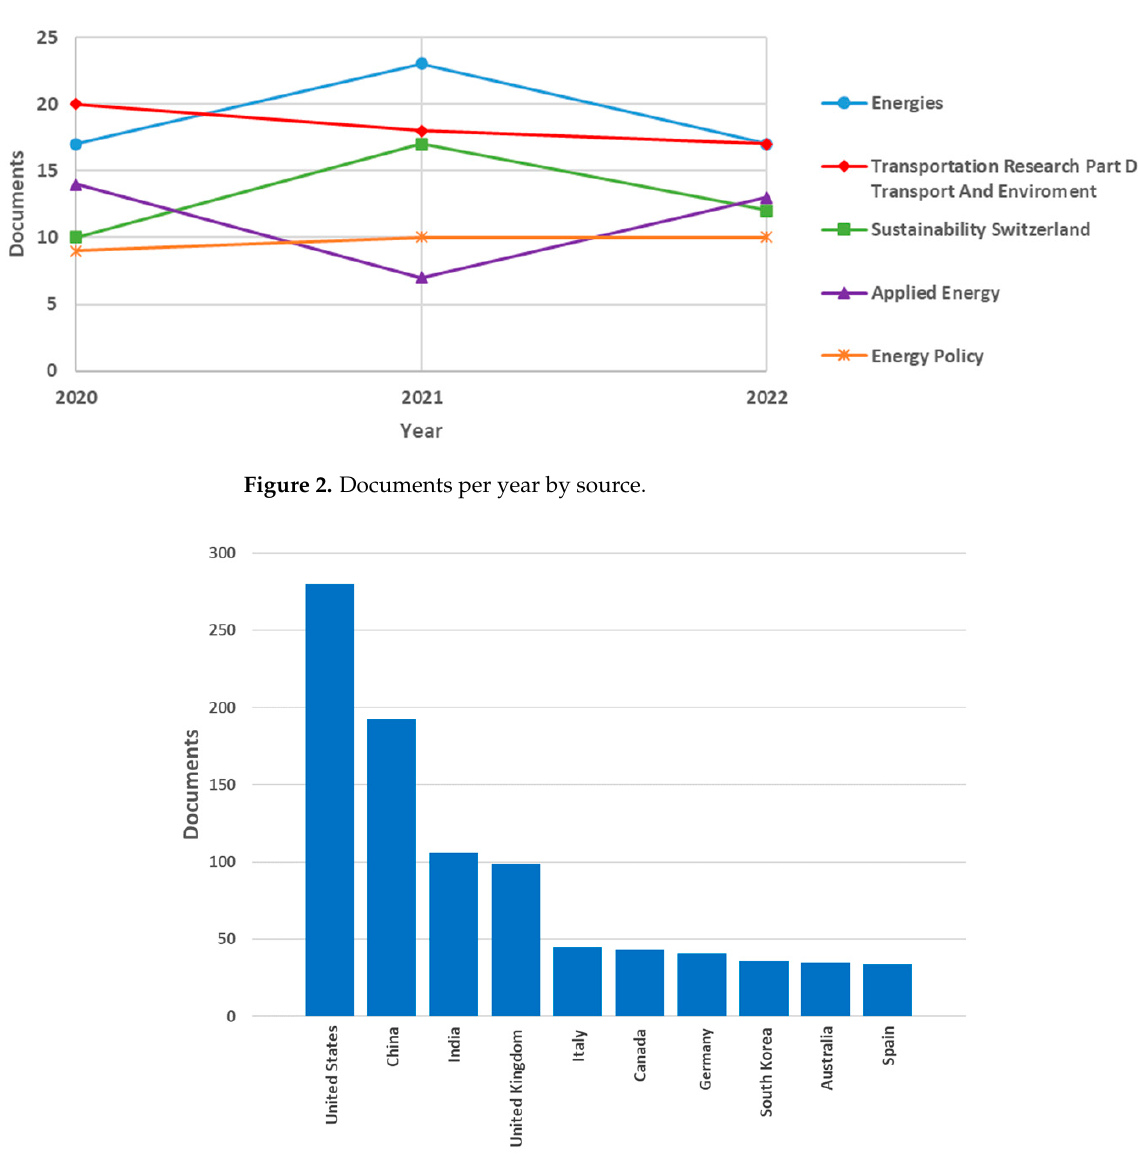
Figure 3. Documents by country/territory .